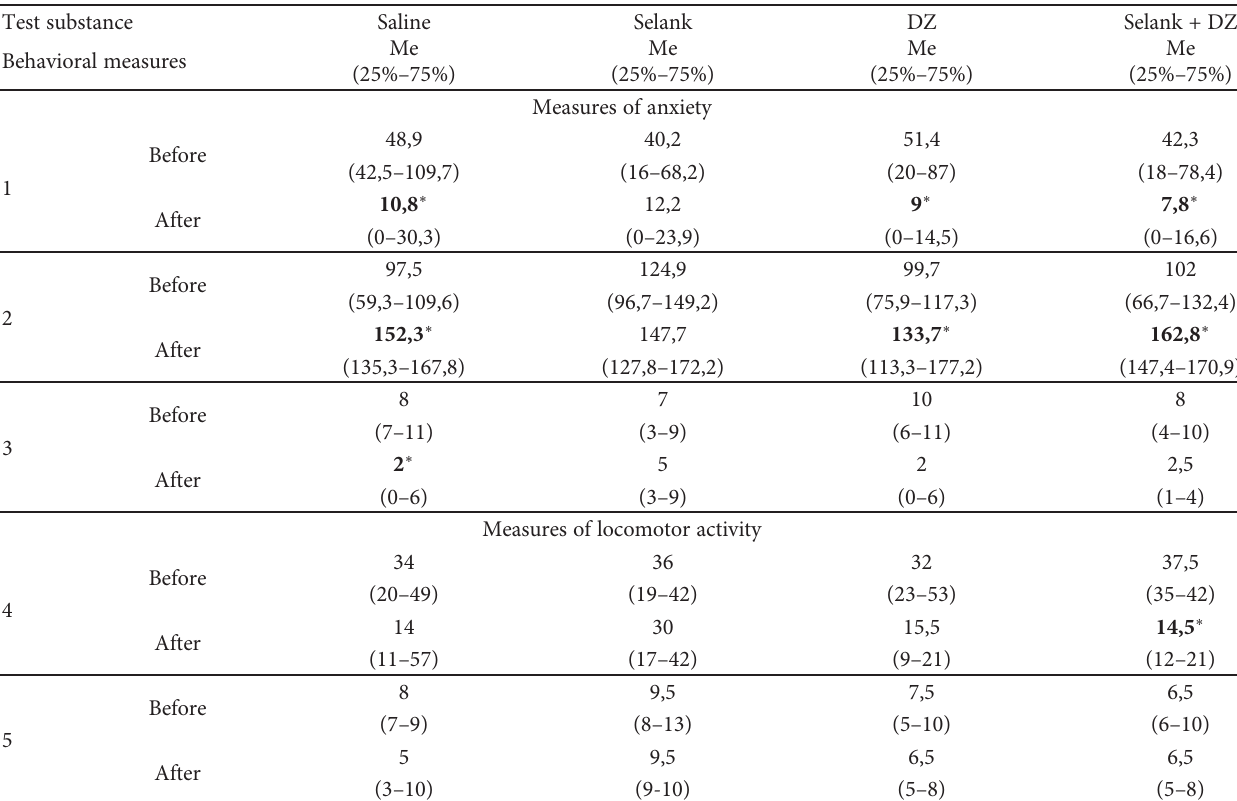
Table 2: Indicators of the behavior of rats that were not exposed to chronic unpredictable stress at the EPM test before and after the administration of the test substances. 1, time spent in the open arms of the maze, s; 2, time spent in the closed arms of the maze, s; 3, number of hanging events from the open arms; 4, number of squares crossed; 5, number of